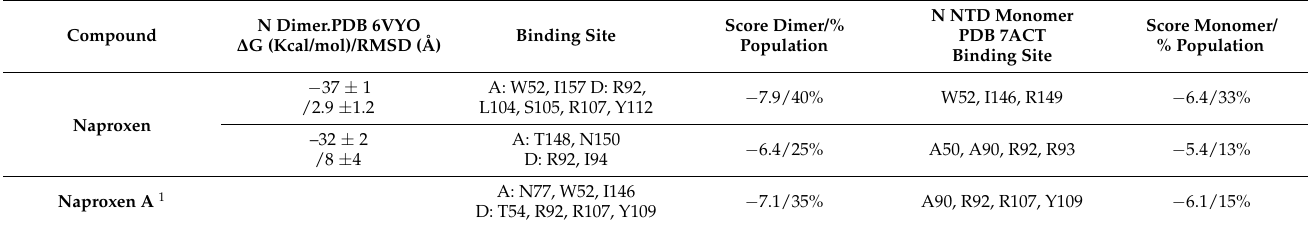
Figure 1. Structural comparison of viral nucleoproteins N. ( A ) Influenza A 2IQH.pdb and of amino-terminal domains of ( B ) SARS-CoV-1 1SSK.pdb ( C ) MERS-CoV 6KL2.pdb ( D ) SARS-CoV-2 6VYO.pdb. Electrostatic surface potentials are computed according to Adaptive Poisson-Boltzmann Solver Electrostatics plugin from PyMOL in standard parameters. Electronegative potentials are colored red while electropositive potentials are colored blue. A large electropositive cleft is visible on each protein, pointed with a green arrow; it maps the putative RNA interaction sites. ( E – H ) Main chains flexibilities are approximated as crystallographic b-factors, with main chain ribbon diameter proportional to b-factor value; red is highest b-factor while blue is lowest b-factor. Most mobile elements are identified by a red asterisk (*); they group on one external side of the protein, facing solvent. Mobile elements of highest b-factors are proximal to electropositive surfaces, supporting an interaction scenario where (1) RNA docks onto an electro-complementary surface before (2) the protein conformation is induced into the N-RNA complex of highest stability. ( I ) Pairwise structural alignment of SARS-CoV-1 (blue), MERS-CoV (green) and SARS-CoV-2 (orange) nucleoproteins. The red arrow emphasizes the conserved RWYFYY sequence. Images were ray traced with PyMOL version 2.0.6. Orientations were selected to highlight discussed properties. Table 1. Binding sites on N NTD in dimeric (subunits A and D in PDB 6VYO) or monomeric forms, of naproxen, naproxen derivatives and two NSAIDs-like drugs as deduced from modeling